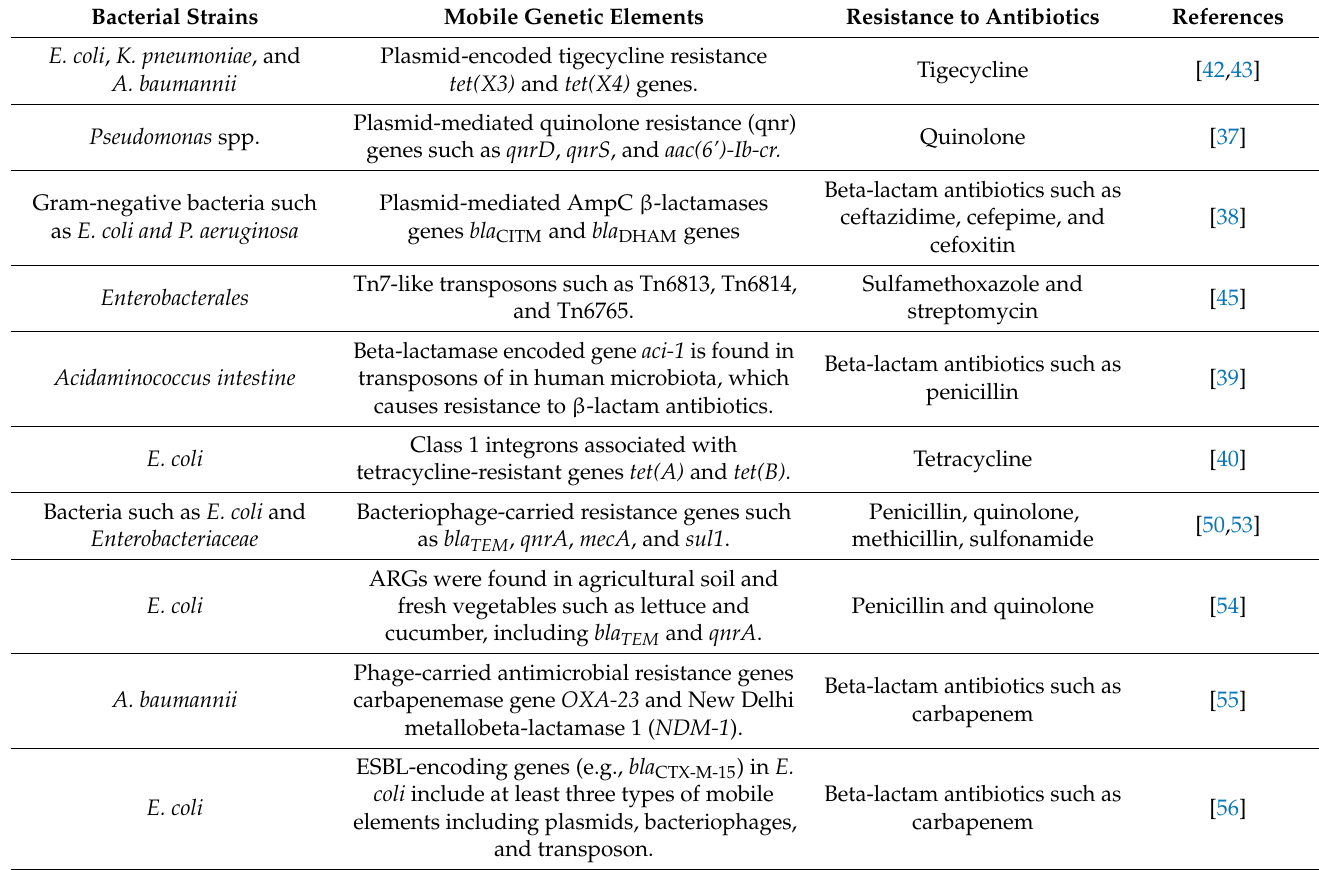
Table 2. Mobile genetic elements in bacteria responsible for antibiotic